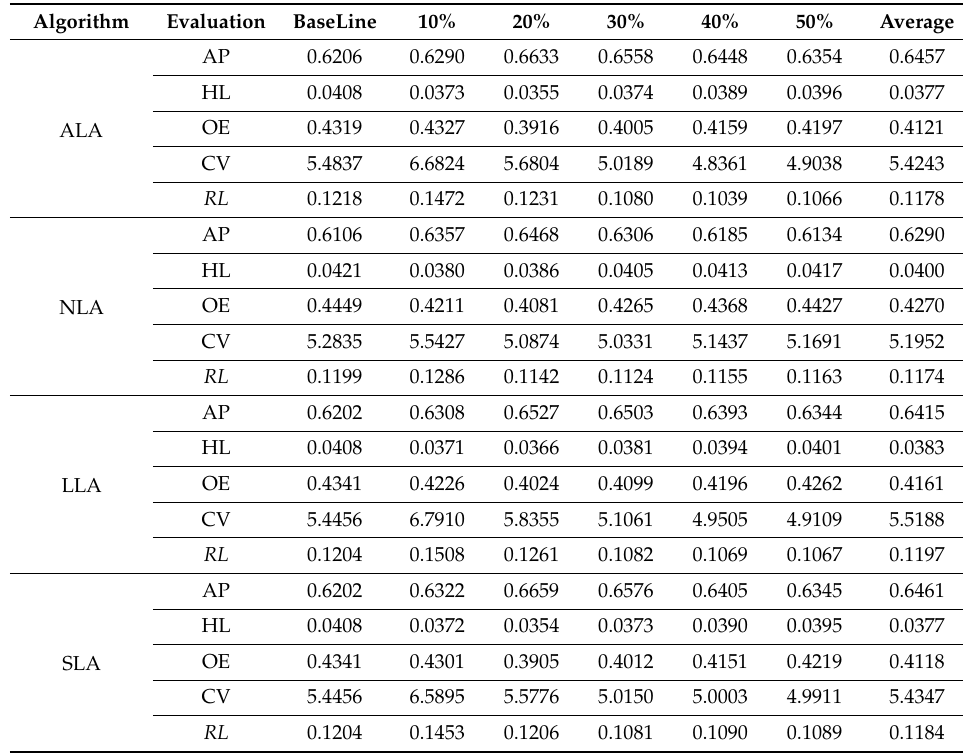
Table 5. Experimental results on Computers data set.